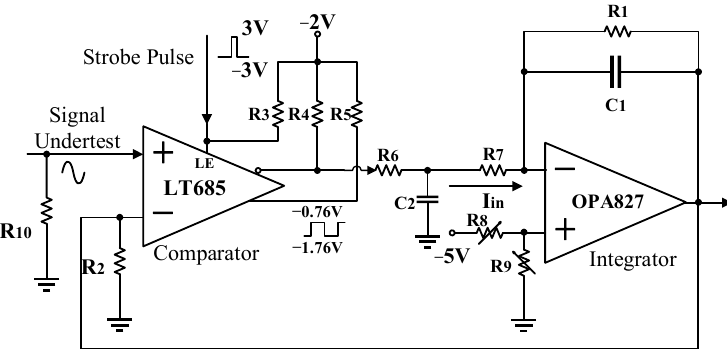
Figure 6. Equivalent-time sampling voltage tracking